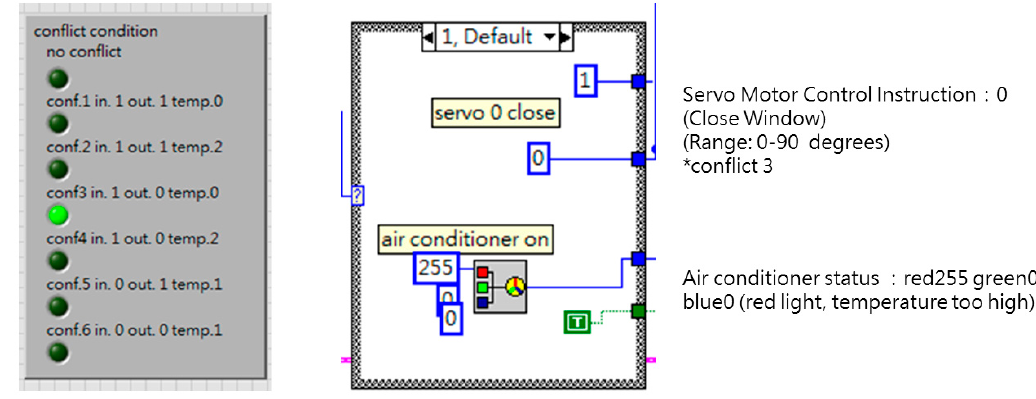
Figure 19. Rule 3 and its case structure.